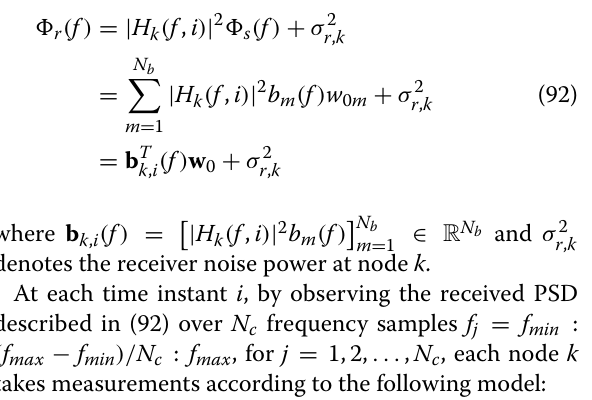
numerical stability of the DRLS algorithm by keeping better tracking of the variations.